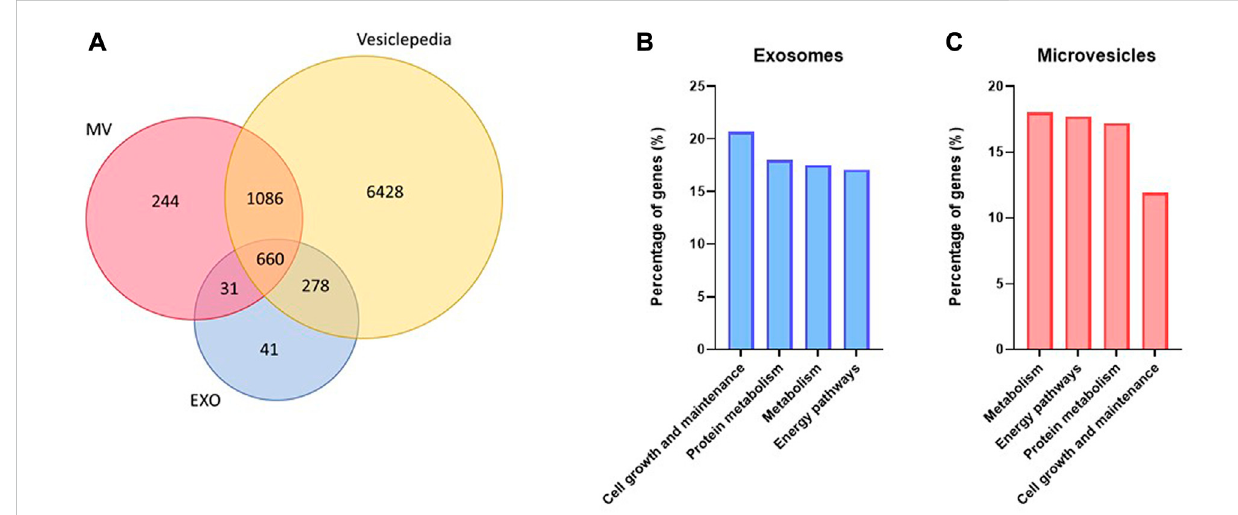
FIGURE 5 Protein content in unstimulated myotube derived extracellular vesicles. Extracellular vesicles were isolated from human myotube cell media after 24 h collection. The protein content of both exosomes (EXO) and microvesicles (MV) were detected by nanoLC-MS/MS and identi fi ed by MaxQuant against theUniprot database.About1000proteins weredetected inEXOand2000inMV,andmostofthese werefound inVesiclepedia (A) . FunRich was used to predict which biological processes the detected proteins were signi fi cantly ( p < 0.01) associated with in exosomes (B) and MV (C)